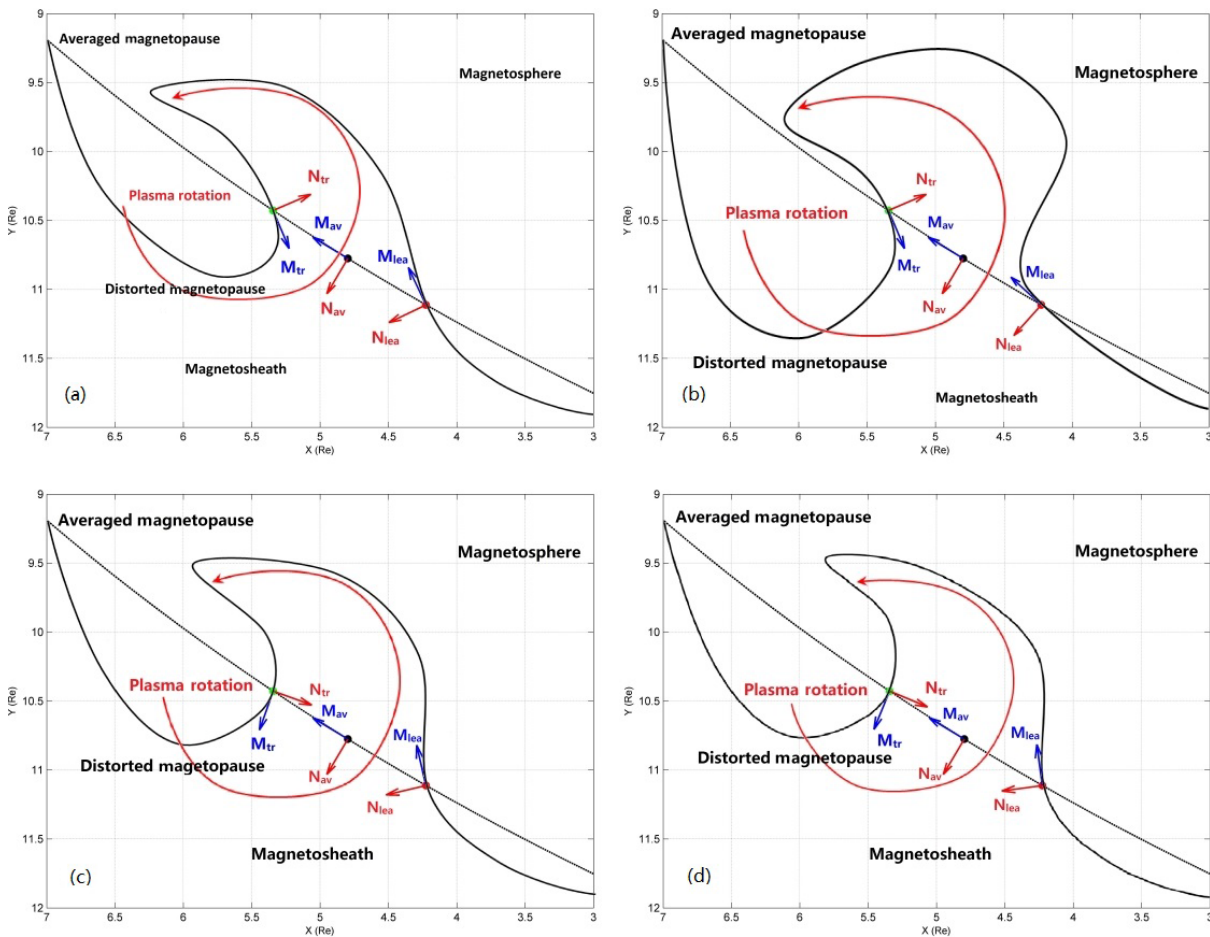
Figure 4. The magnetopause distortions formed by the K–H vortices deduced by the MVA. The average magnetopause (dashed lines), approximated to the spacecraft trajectory, was calculated from the magnetopause model (Shue et al., 1998). Traversal pair at 22:24UT in panel (a) : M lea = (0.4374, − 0.8141, − 0.3819) and N lea = (0.8970, 0.4251, 0.1212) at the outbound crossing; M tr = ( − 0.3877, 0.8830, 0.2645) and N tr = ( − 0.9195, − 0.3906, − 0.0438) at the inbound crossing. Traversal pair at 22:32UT in panel (b) : M lea = (0.8349, − 0.3995, − 0.3786) and N lea = (0.5504, 0.6081, 0.5721) at the outbound crossing; M tr = ( − 0.3946, 0.8595, − 0.3248) and N tr = ( − 0.9171, − 0.3900, 0.0821) at the inbound crossing. Traversal pair at 22:36UT in panel (c) : M lea = (0.1004, − 0.8420, − 0.5301) and N lea = (0.9594, 0.2231, − 0.1726) at the outbound crossing; M tr = (0.3363, 0.9417, − 0.0076) and N tr = ( − 0.9417, 0.3362, − 0.0135) at the inbound crossing. Traversal pair at 22:39UT in panel (d) : M lea = (0.0363, − 0.9014, − 0.4314) and N lea = (0.9724, 0.1315, − 0.1930) at the outbound crossing; M tr = ( − 0.5073, − 0.5145, − 0.6913) and N tr = ( − 0.8599, 0.3556, 0.3662) at the inbound